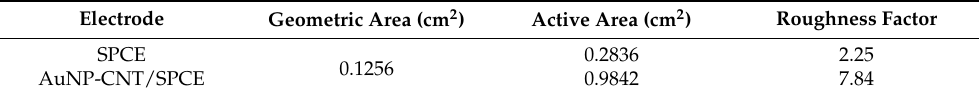
Table 2. Geometric area, active surface area and roughness factor for SPCE and AuNP-CNT/SPCE. Electrode